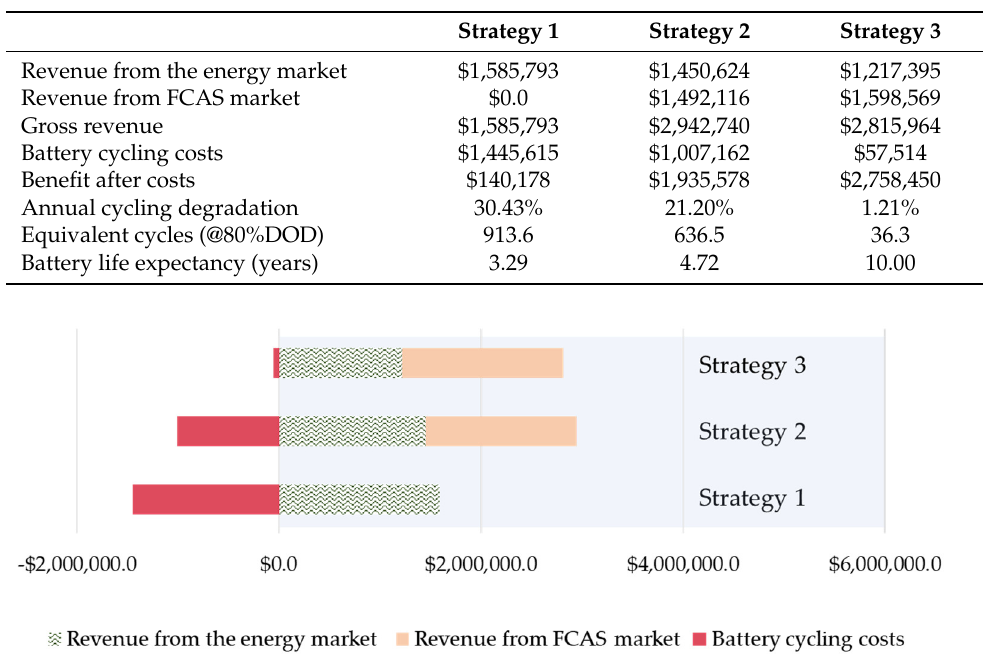
Figure 12. Cost and revenue breakdown for each BESS strategy.